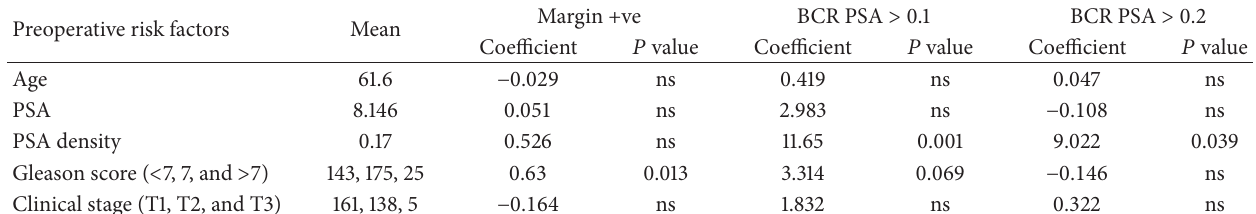
Table 4: Multivariate binary logistic regression of preoperative risk factors and outcome of RALP.